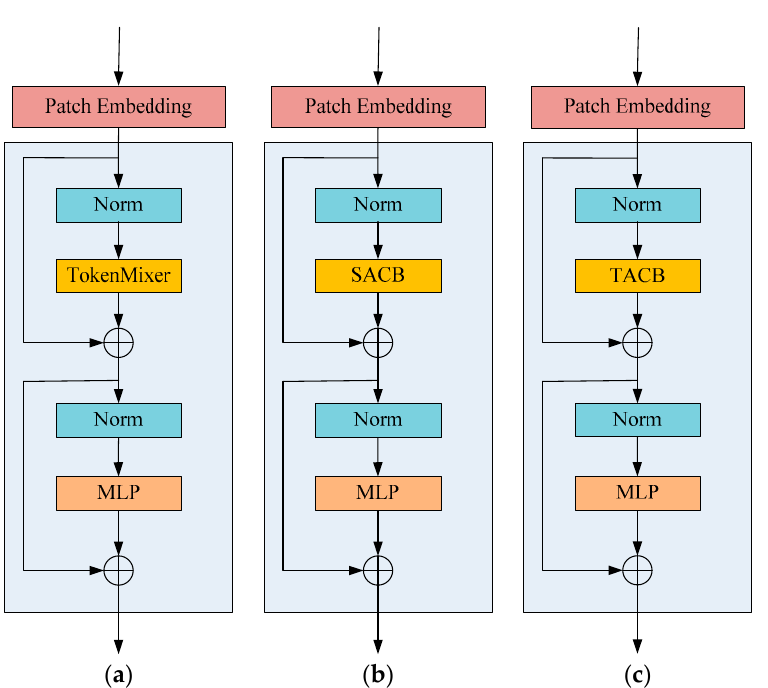
Figure 2. Comparison of MetaFormer block, Spatial Attention Former Block, and Temporal Attention Former Block. ( a ) MetaFormer Block. ( b ) Spatial Attention Former Block (SAFB). ( c ) Temporal A tt ention Former Block (TAFB).